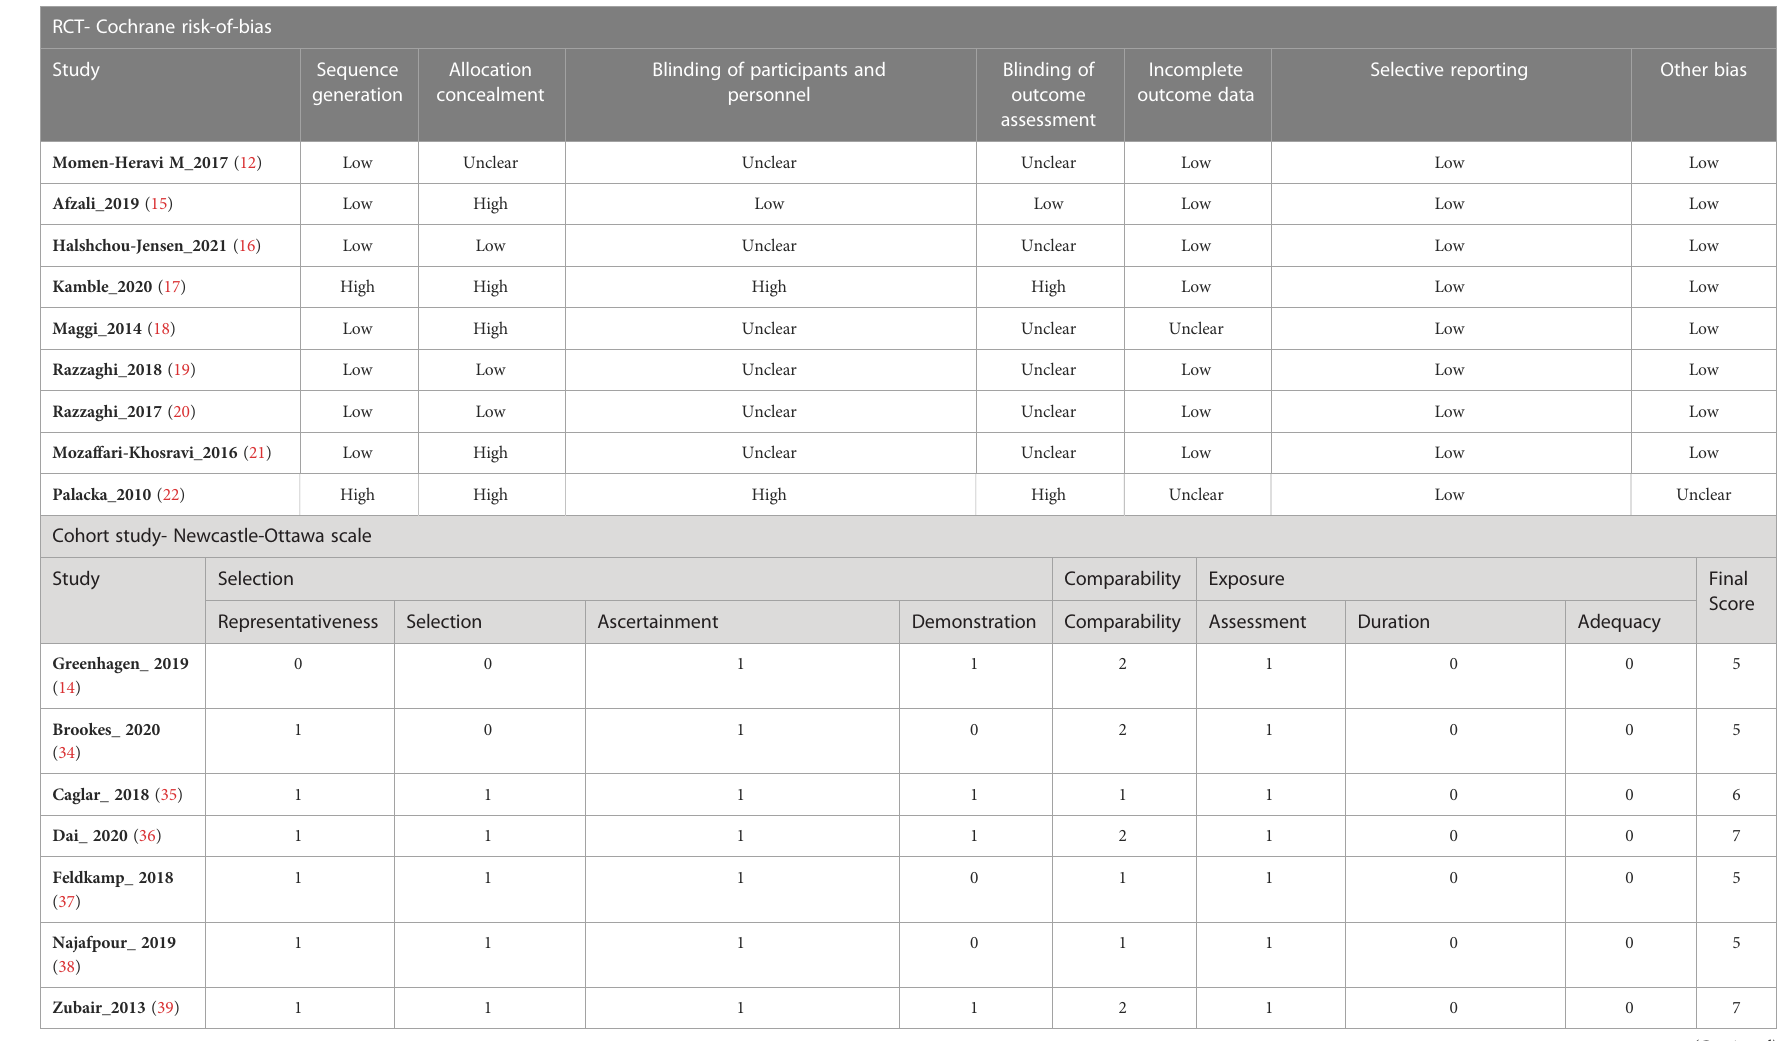
TABLE 2 Risk of bias assessment using Cochrane risk-of-bias tool for RCTs and Newcastle-Ottawa scale for observational studies, and Joanna Briggs Institute (JBI) critical appraisal checklist for cross-sectional